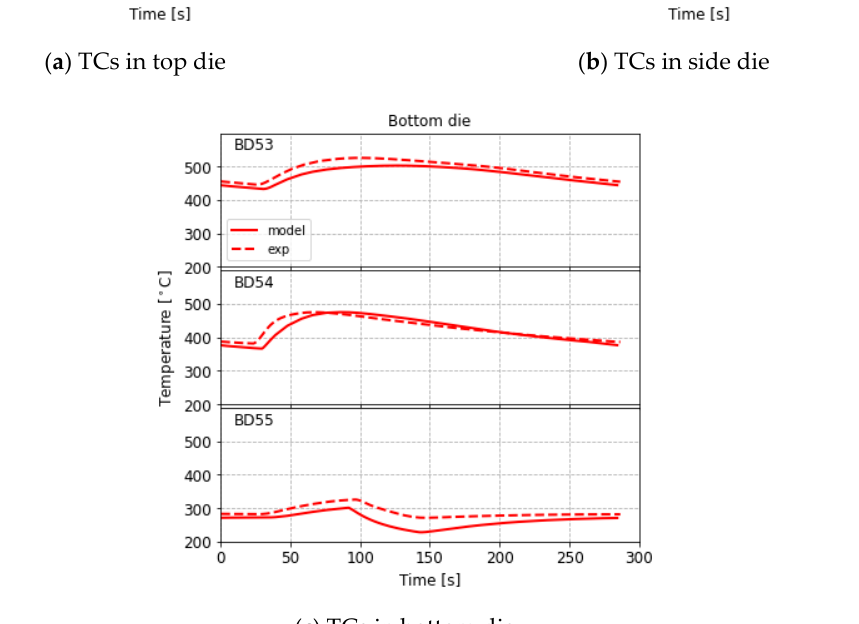
Figure 22. Error between the model and measured data.